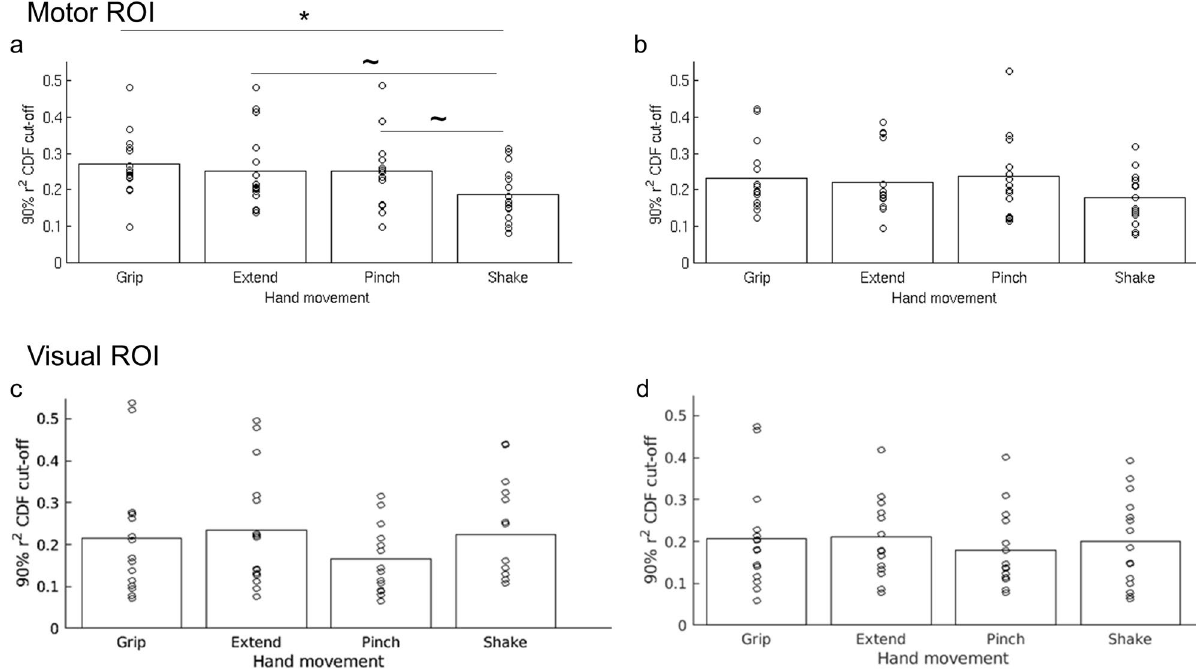
Figure 4. (a) r 2 cut-off values of the four different hand movements’ patterns in the pre-task rest data (all participants). Grip had the highest cut-off value indicating that this pattern was most represented in the pre-task spontaneous activity. The lowest cut-off value was that of the Shake condition, indicating the it was the least represented pattern in the pre-task resting data. The difference between the Grip and the Shake conditions was significant following a correction for multiple comparisons (*). Both comparisons—Extend vs Shake, and Pinch vs Shake were significant before correction, but did not survive the correction for multiple comparisons ( ~). (b) r 2 cut-off values in the post-task rest data. No significant differences were found in the post-task data in terms of r 2 cut-off values of the different conditions. Bottom panels: r 2 cut-off values in the pre-task rest (c) and post-task rest (d) data in the visual area. No significant differences were found in both timepoints in terms of r 2 cut-off values of the different conditions.